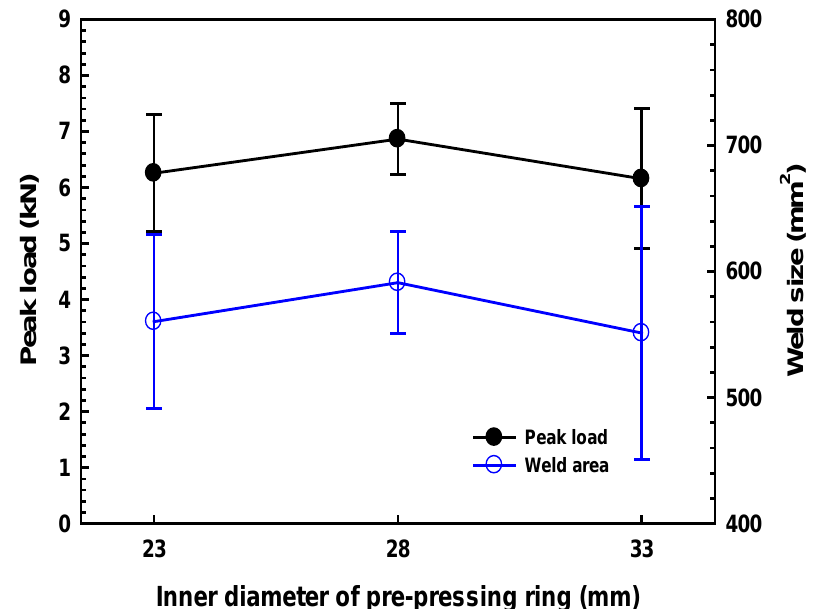
Figure 4. Effect of the diameter of the PPRC on the joint strength and weld size of the UW joints